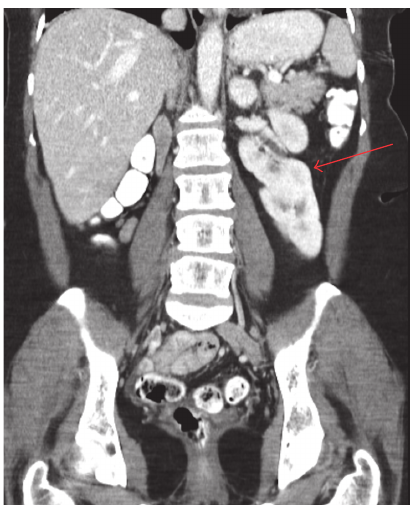
Figure 3: A coronal contrast-enhanced CT image shows an ectopic right kidney fused to the lower pole of the left kidney.